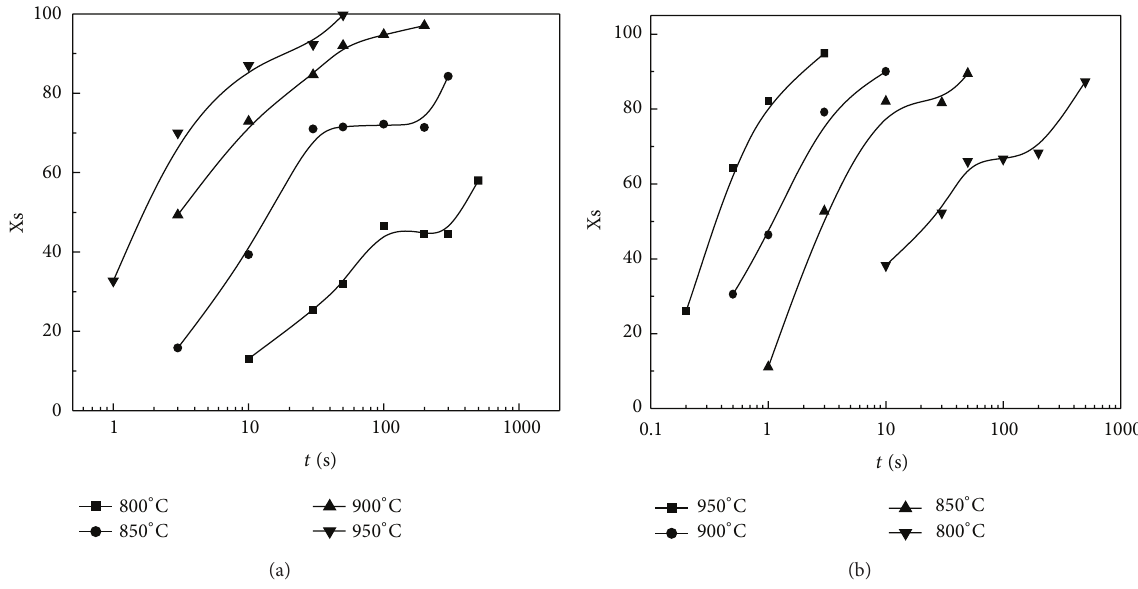
Figure 2: The softening curves of the tested steel. (a) True strain 𝜀 = 0.22 ; (b) true strain 𝜀 = 0.35